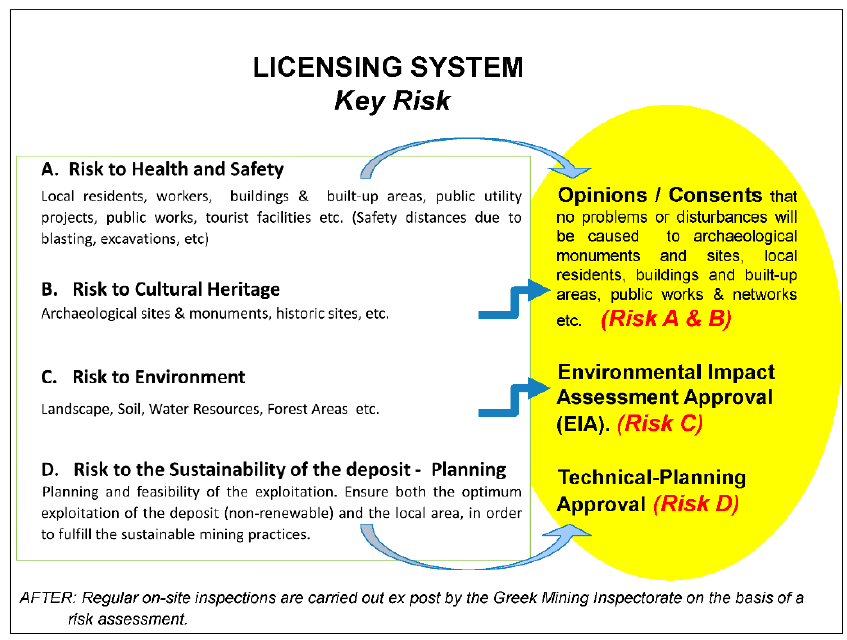
Figure 5. Key risk factors regarding the licensing system. Table 3. Annual fees for mines and quarries.